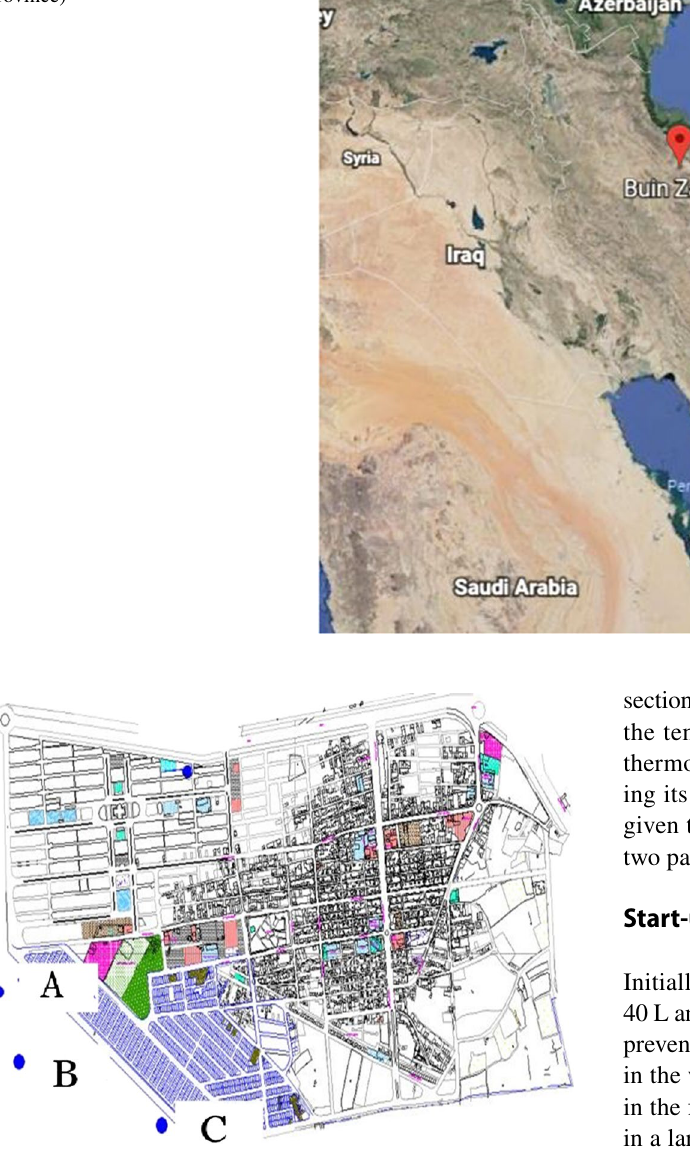
Fig. 1 Location of sampling region, south of Qazvin plain (50 km to the center of the